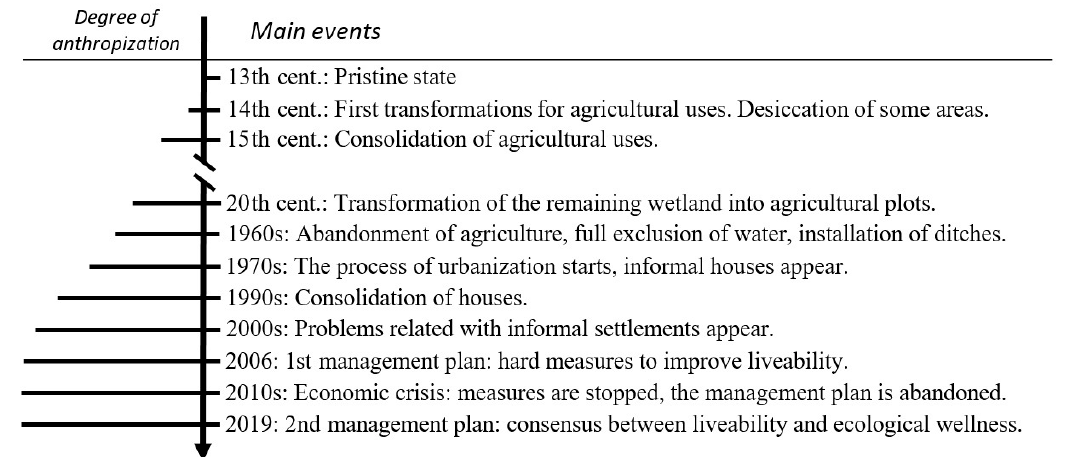
Figure 2. Timeline of socio-economic and environmental changes in La Marjaleria, Spain. For the purposes of the SES assessment of La Marjaleria, the time boundaries of the system were defined by the historical record from the 14th century (Figure 2). Prior to 1950, La Marjaleria was agricultural land and major policy changes from 1950 onwards disrupted the former structure and function of the previously stable arable landscape. which land use transformation took place. The total area of the SES is 7.8 km 2 , distributed at 2–7 m